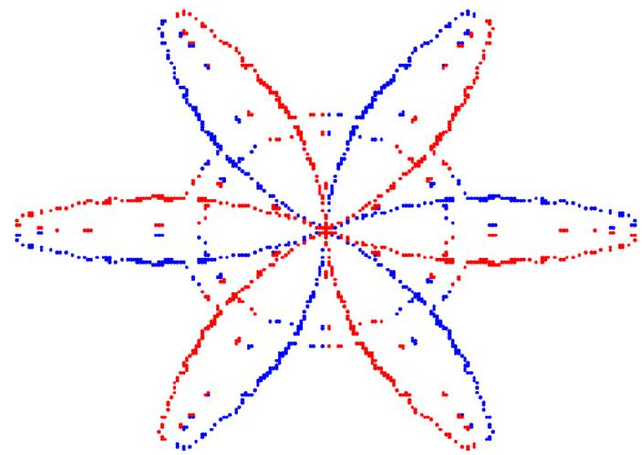
Figure 21. A poor connection on a PV module .